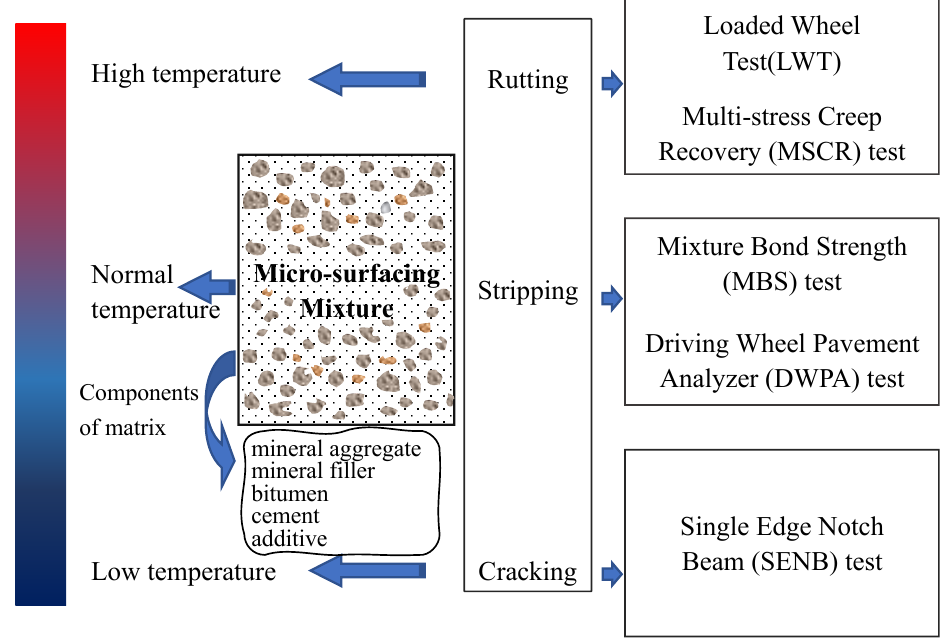
Figure 1. Experimental